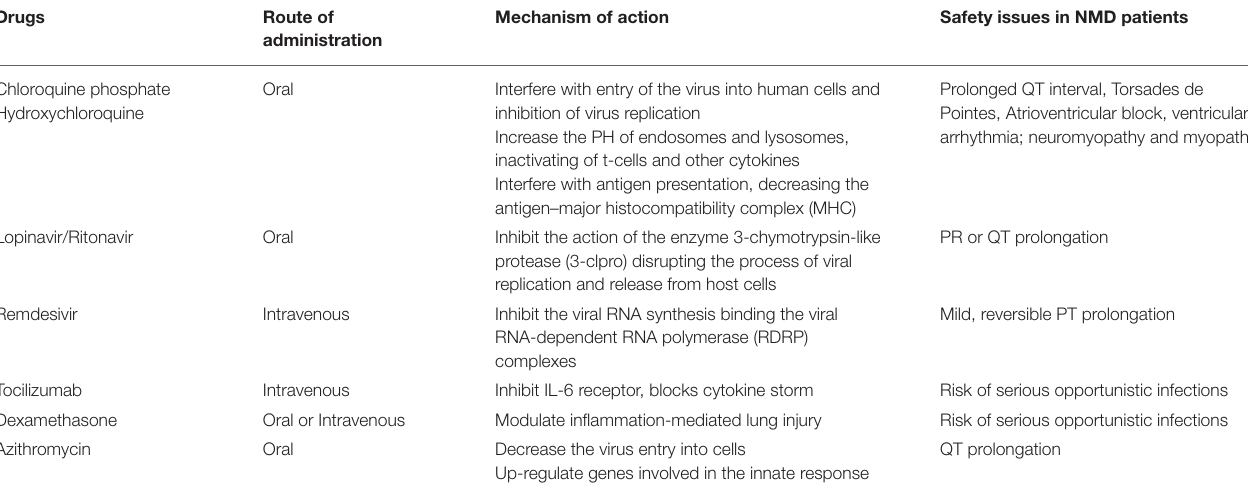
TABLE 2 | Mechanism of action, route of administration, and safety of drugs used in clinical practice for COVID-19 therapy.